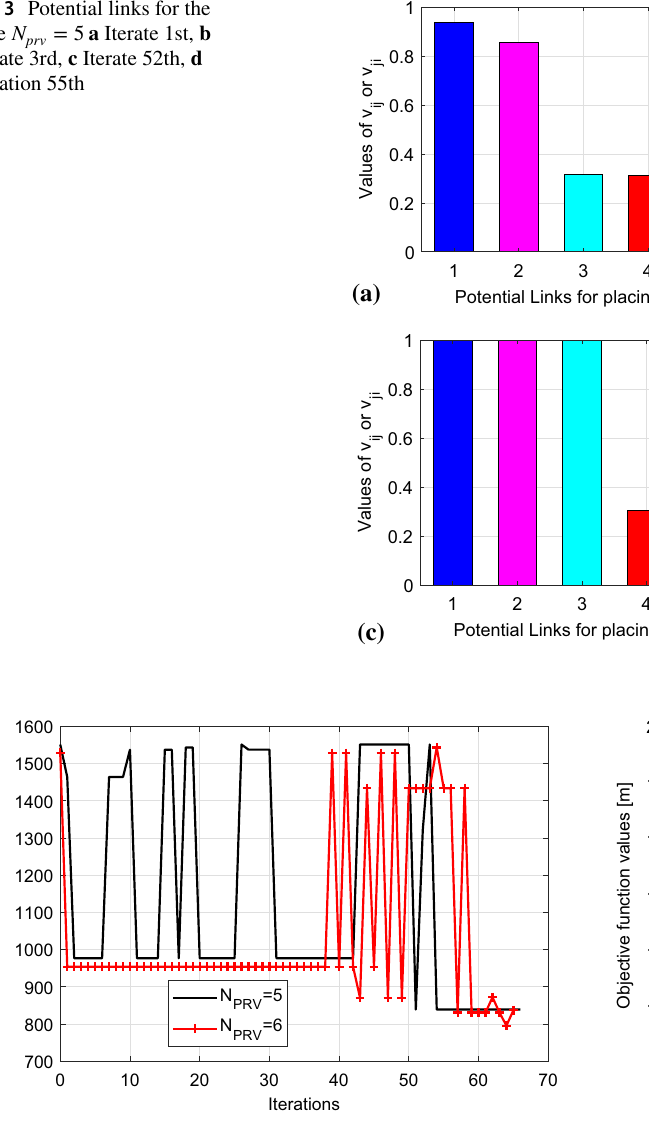
Fig. 4 Profile of objective function values for N prv = 5,6 Fig. 5 Profiles of objective function